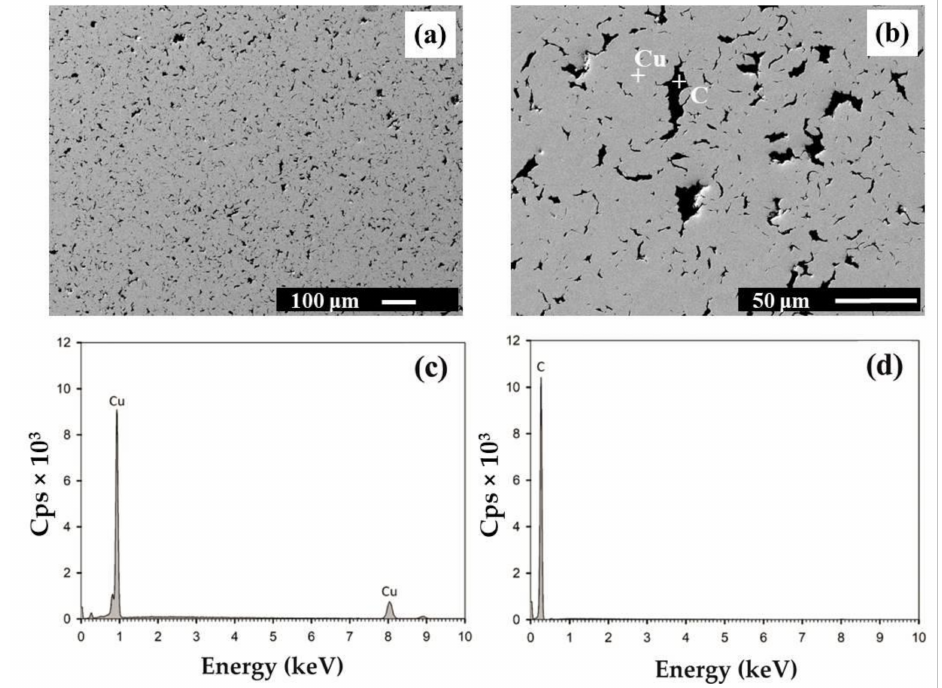
Figure 2. SEM microstructure of the Cu–graphite sample with 10 vol. % graphite at magnification 100 × ( a ) and 500 × ( b ). Cu and graphite are colored in light grey and black, respectively. EDS spectra were obtained by point analysis in Cu ( c ) and C ( d